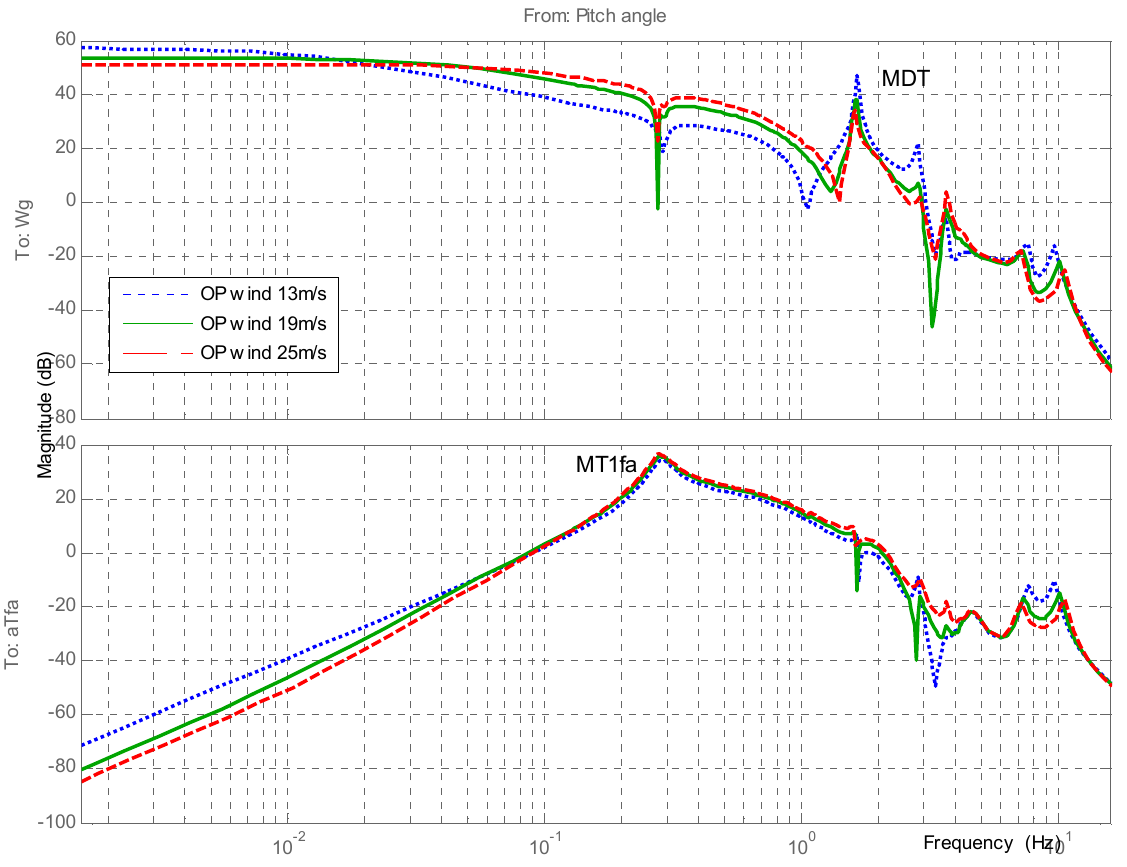
pitch controller ∞